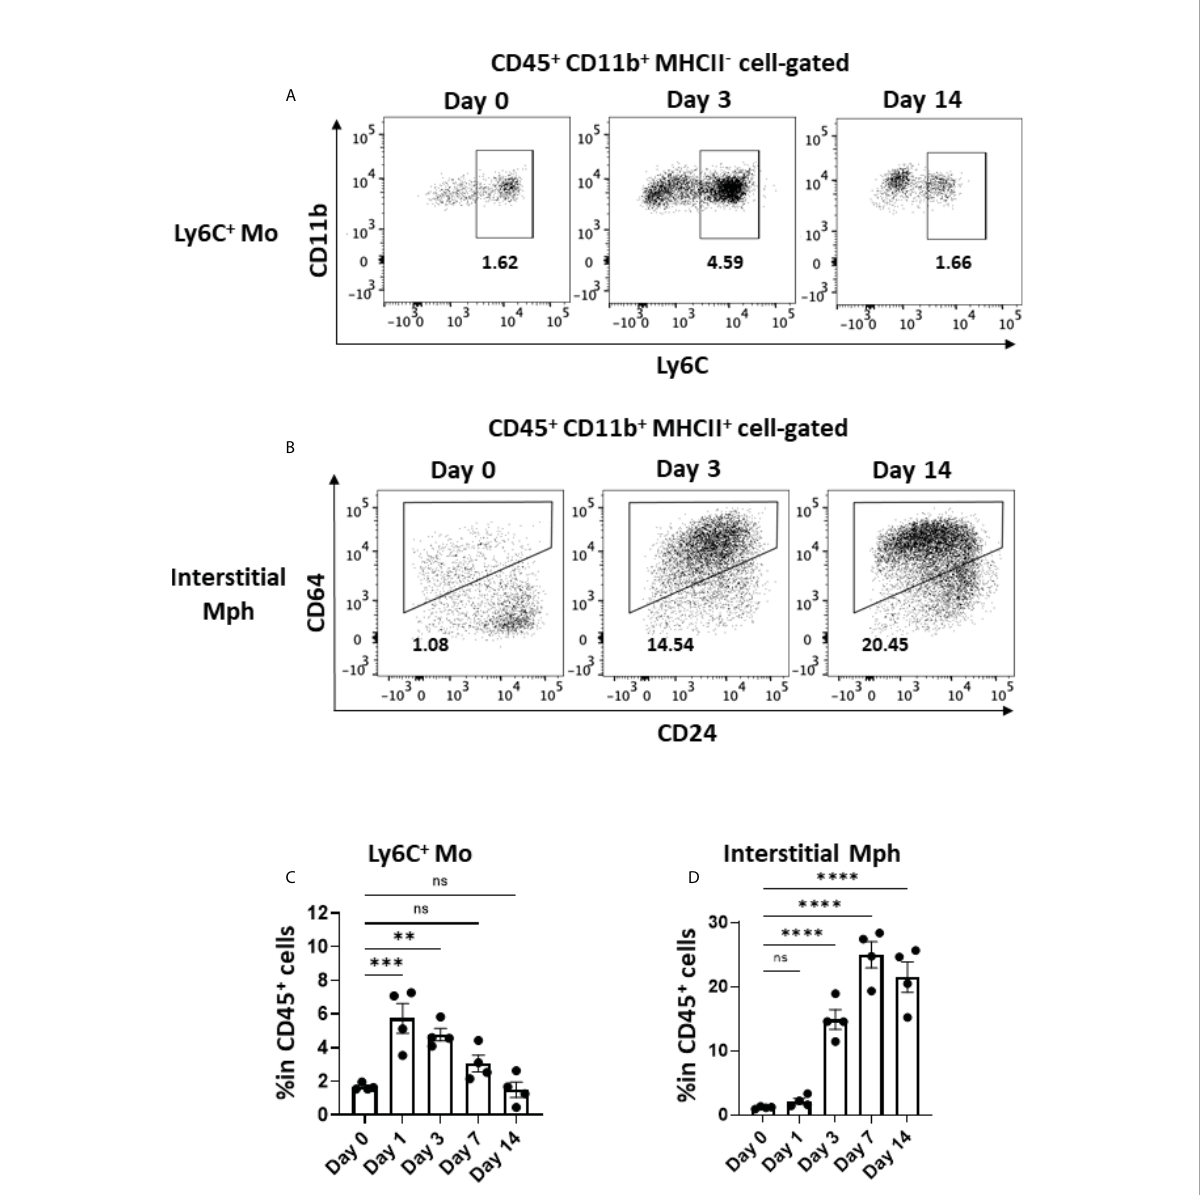
FIGURE 5 Monocyte migration and accumulated interstitial macrophages in the early phase in BLM-ILD. A lung cell suspension was obtained from mice before and 3 and 14 days after the instillation of BLM and stained with fl uorochrome-conjugated antibodies for CD45, CD11b, I-Ab CD24, and CD64. (A, B) Representative cytograms showing Ly6C+ monocytes (Mo) (A) and interstitial macrophages (Mph) (B) on the indicated days. The number indicates the percentage in CD45+ cells. (C, D) Frequencies of Ly6C+ monocytes (C) and interstitial macrophages (D) in CD45+ cells in the lungs from pooled mice. n = 4 per day. Data are presented as the mean ± SEM. Statistics show p-values from a one-way ANOVA with Dunnett ’ s multiple comparisons test as the post-hoc test comparing values on day 0. ns, not signi fi cant. **p < 0.01; ***p < 0.001; ****p <